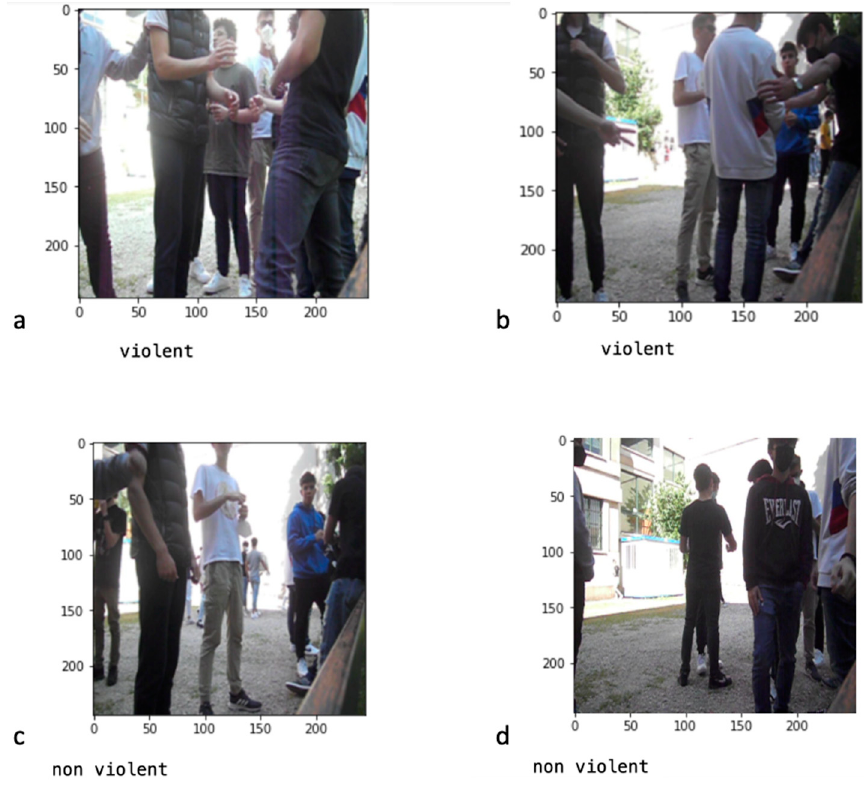
Figure 6. Running examples of the final output of the SVD that recognizes ( a , b ) violent and ( c , d ) non-violent scenes.